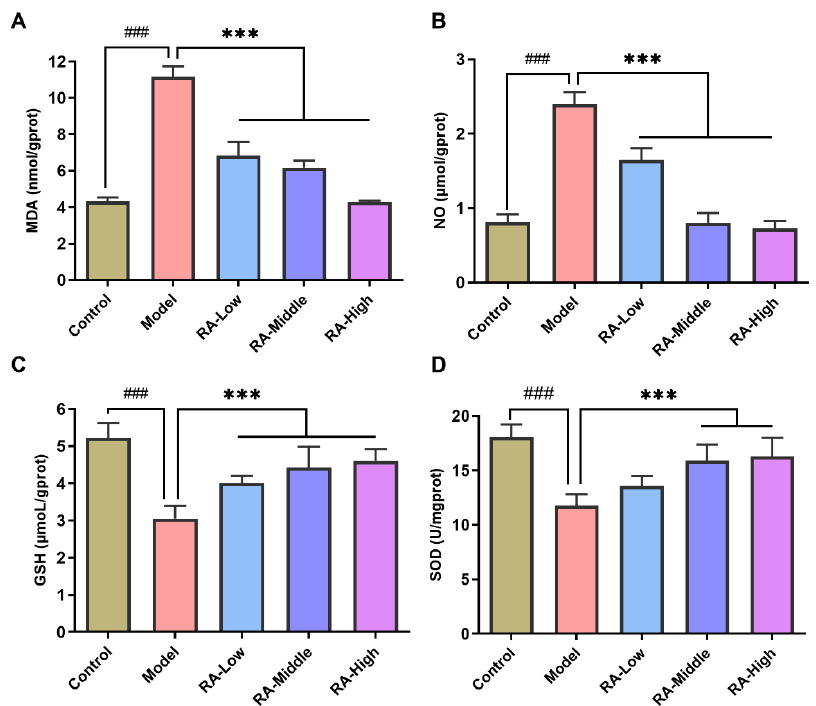
Figure 4. Effects of RA on the liver MDA, NO, SOD, and GSH levels. Liver levels of MDA ( A ), NO ( B ), GSH ( C ), and activity of SOD ( D ) were assayed. ### p < 0.01 compared with the PBS group; *** p < 0.01 compared with the OVA model group.